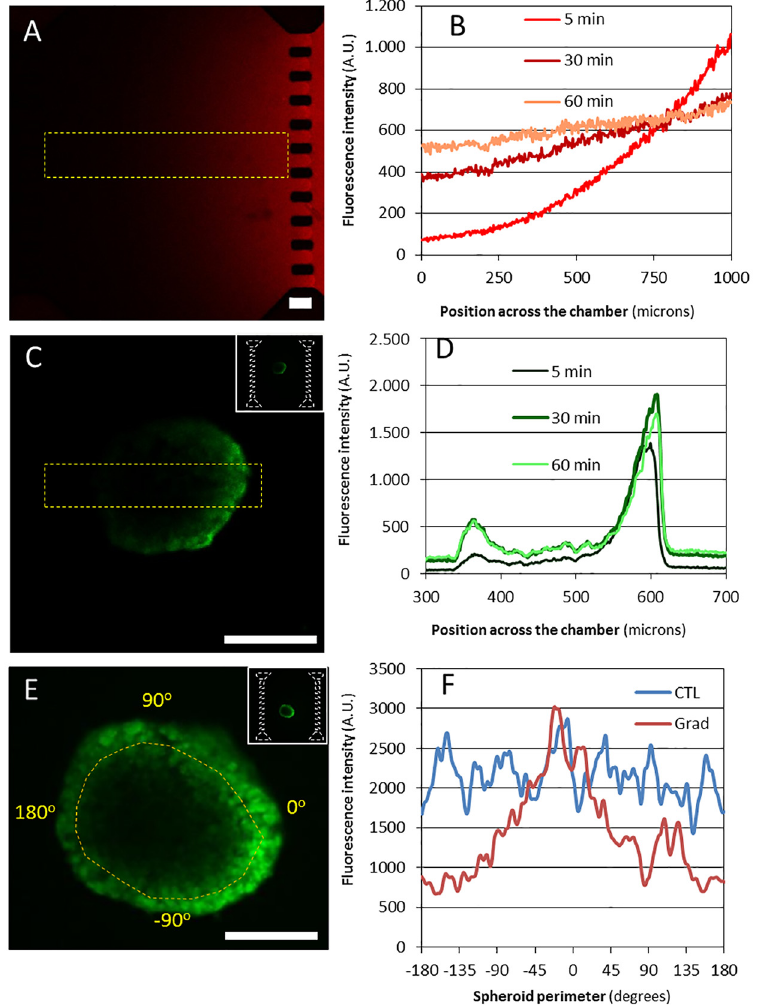
Fig 2. Chemical gradient across the microchamber. (A) A complete image of the microchamber 5 minutes after red fluorescent Rhodamine B was perfused through the right lateral microchannel. (B) Evolution of fluorescence intensity of Rhodamine B along the whole microchamber width (as highlighted in yellow in A) over time. (C) An image of an OSC – 19 spheroid after 5 minutes of FDA perfusion through the right lateral microchannel. (D) Fluorescence intensity along the section of the spheroid (as highlighted in yellow in B) after 5 minutes of FDA perfusion. (E) Fluorescence intensity within the spheroid after 1 hour of FDA perfusion. (F) Fluorescence intensity along the spheroid perimeter after 1 hour of FDA perfusion through only one lateral microchannel (gradient condition-blue line) or through the hydrogel (control condition-red line). Images corresponding with the spheroid middle focal plane are shown. Scale bar is 100 μ